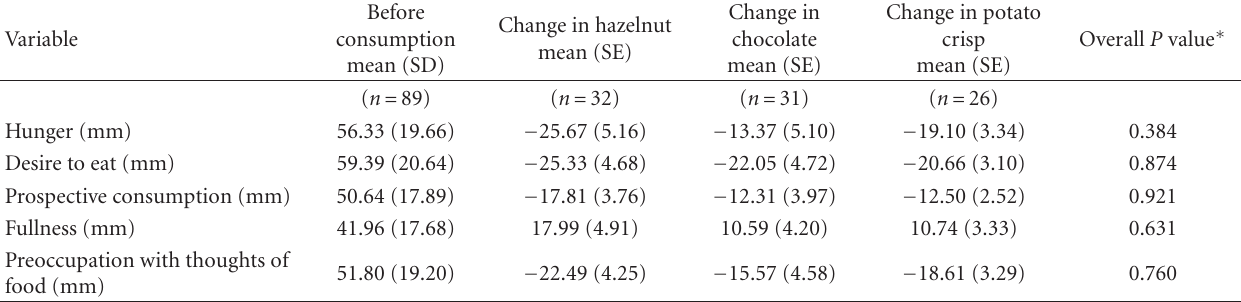
Table 5: Changes in appetite indices before and after consuming study snacks during the